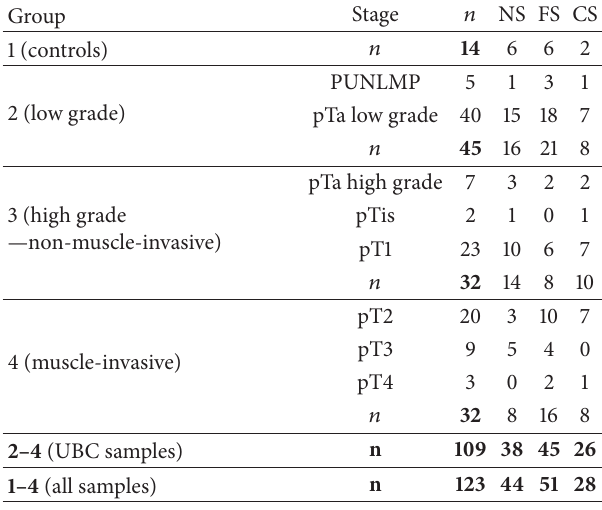
Table 1: Pathologic and smoking characteristics of 109 urothelial carcinoma of the bladder samples and 14